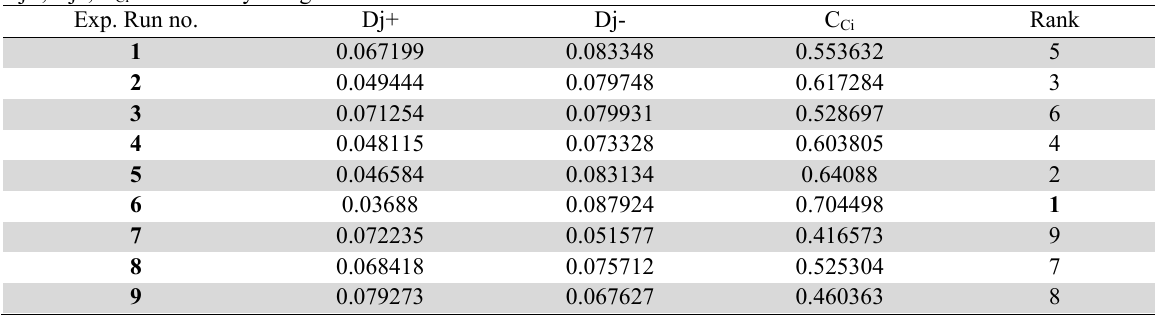
For finding the optimal set of parameters using TOPSIS, Table 2 output responses normalized with Eq. (9). The weights estimated using CRITIC method are utilized here and multiplied with the normalized values using the Eq. (10). Estimation of positive and negative ideal solutions is obtained by using Eq. (11). Further the separation measures using Eq. (12) and the closeness coefficient using Eq. (13). Now, the ranking of alternatives in descending order is carried out based on the closeness coefficient and ranking is established to identify the optimal parameters, which is presented in Table 10. Dj + , Dj - , C Ci and Rank by using the TOPSIS Exp. Run no. Dj+ Dj- C